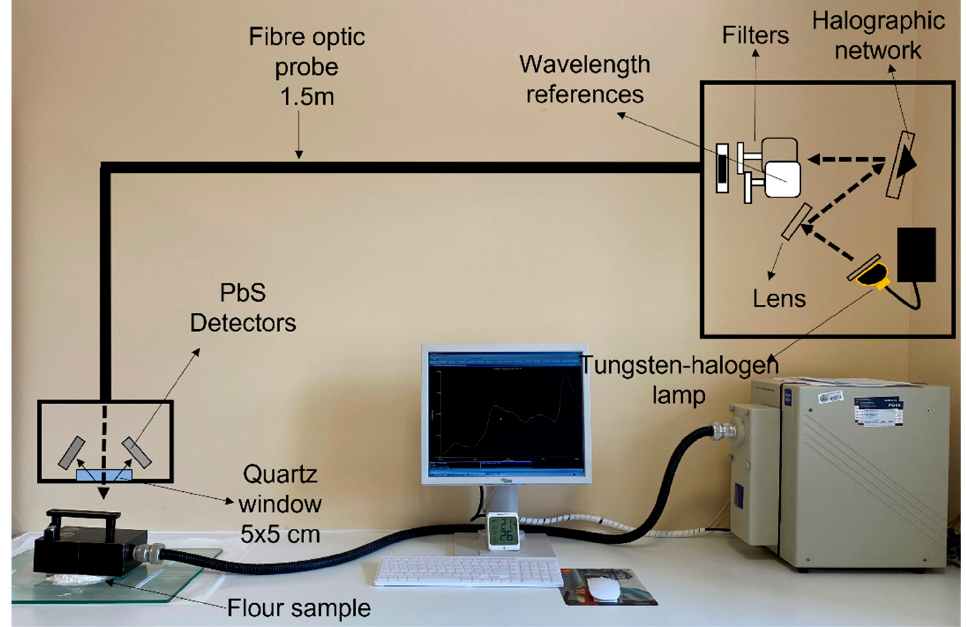
Figure 1. Methodology used for recording the spectra of flour and fortified flour samples.